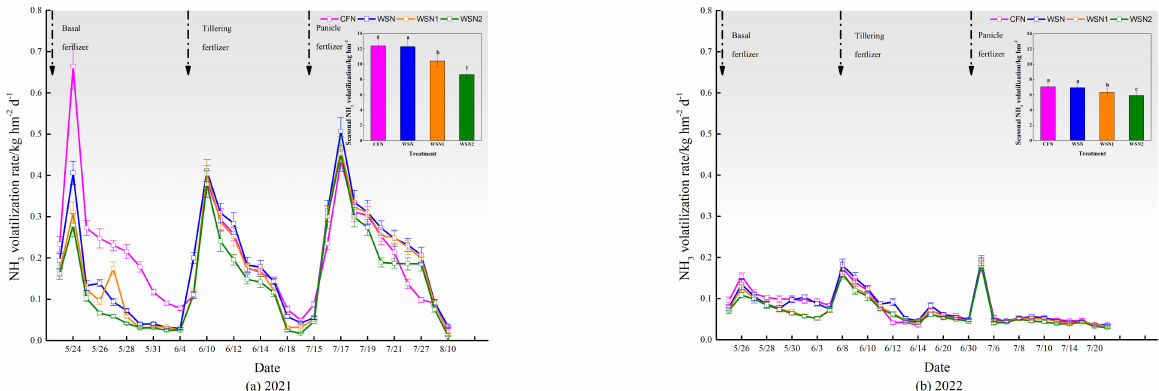
Figure 4. NH 3 volatilization rates and seasonal NH 3 volatilization during the rice cropping season in ( a ) 2021 and ( b ) 2022. Bars represent means SE. Different letters indicate significant differences ( p < 0.05) between different